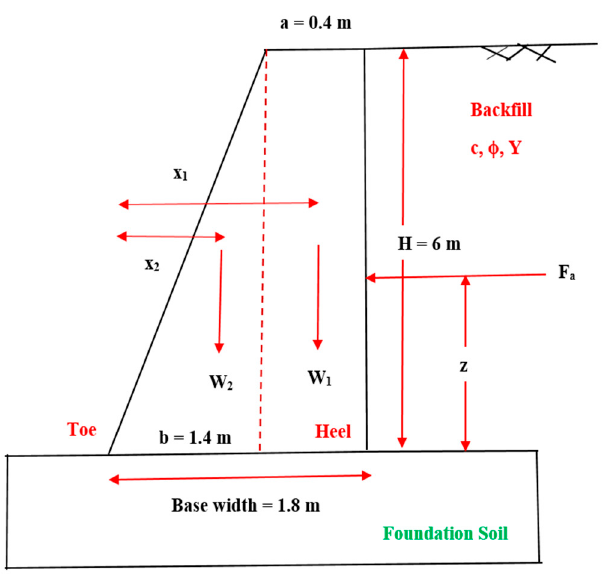
Figure 2. Gravity retaining wall considered for this study. Table 1. Statistical depiction of